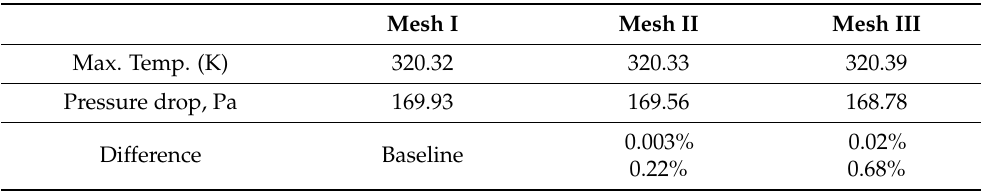
Table 4. Grid independence study; u in = 0.75 m/s.